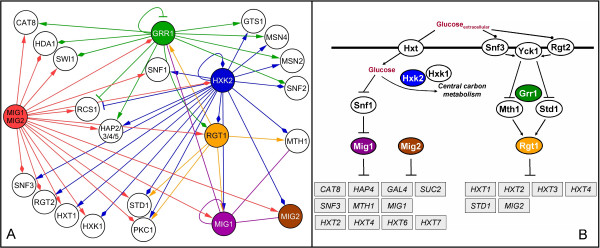
Glucose signaling and regulatory pathway in the yeast S. cerevisiae. A) Inferred regulatory interaction map for glucose repression. We used genome-wide gene expression data from different mutants with deletions in key glucose repression elements (Δgrr1, Δhxk2, Δmig1, Δmig1mig2 and Δrgt1) [9,11] to determine Reporter TFs (p-value < 0.01; see Additional file 1). The graph links the deleted elements (colored nodes) to the corresponding Reporter TFs. The end arrow indicates if the protein is also a 'Reporter TF for Up-Regulated Genes only' (triangular arrow), a 'Reporter TF for Down-Regulated Gene Only (T arrow), both (diamond arrow) or none (no arrow). B) The two main pathways reported in literature for glucose sensing and signaling in yeast.